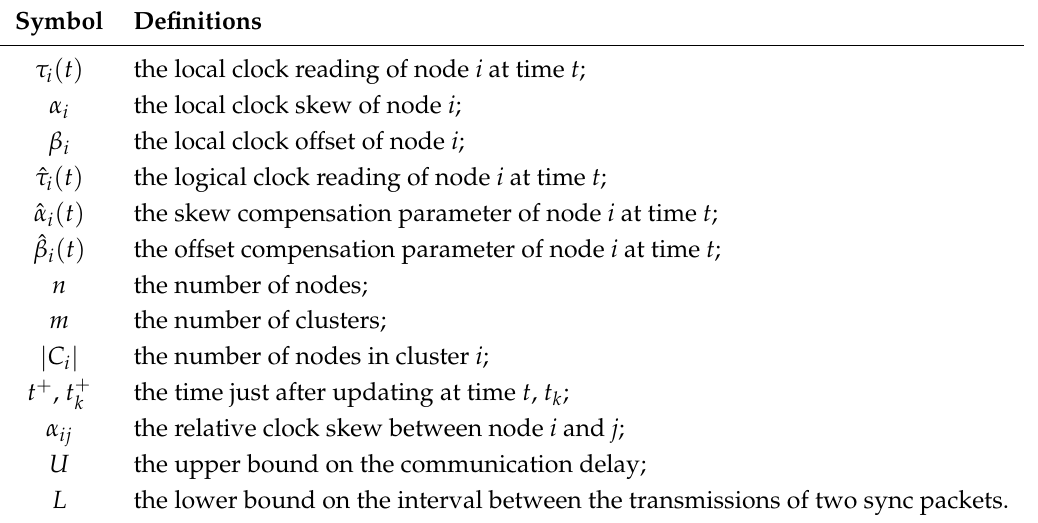
Table 1. Notation definitions.